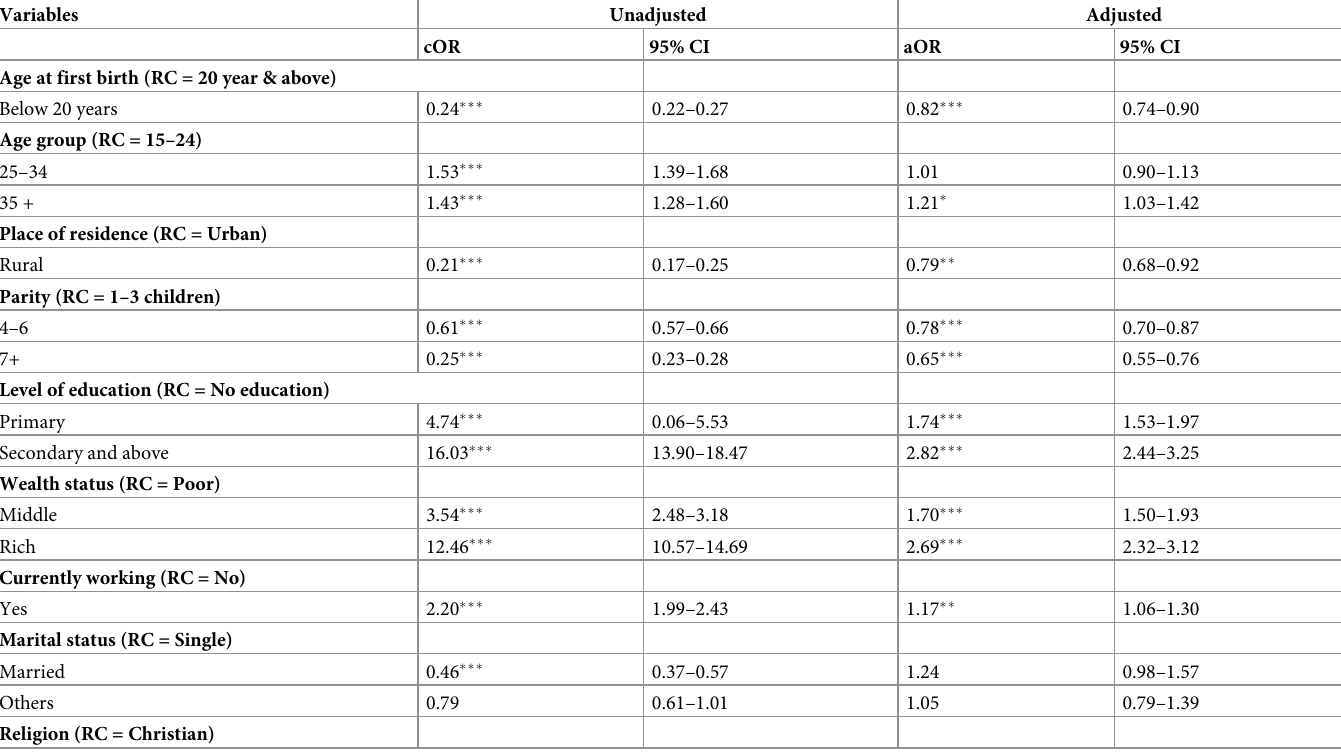
Table 2. Bivariate and multivariable logistics regression results on the predictors of health facility delivery (n = 34,193). Variables